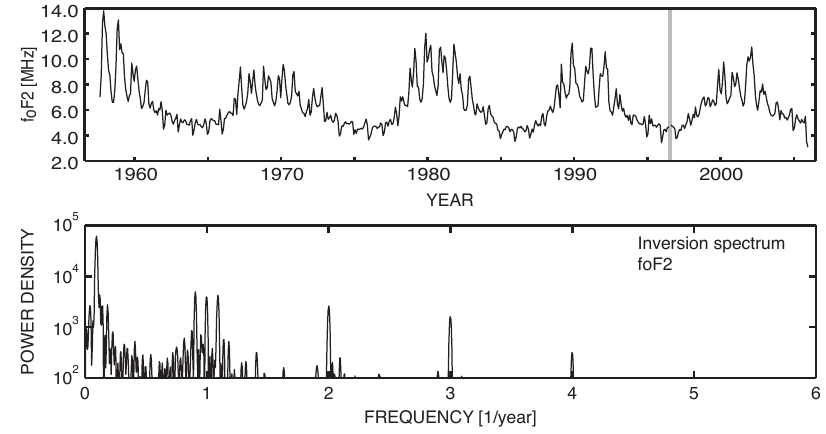
Fig. 7. Top panel: The F layer critical frequency fo F2 from 1957–2006, as observed by the ionosonde at Sodankyl¨a, Finland. The data points are mean values at 10:00–14:00LT from the middle day of each month. Bottom panel: The inversion spectrum calculated from the data in the top panel. The whole spectrum consists of 1200 frequencies and the frequency resolution is 5 . 004 × 10 − 3